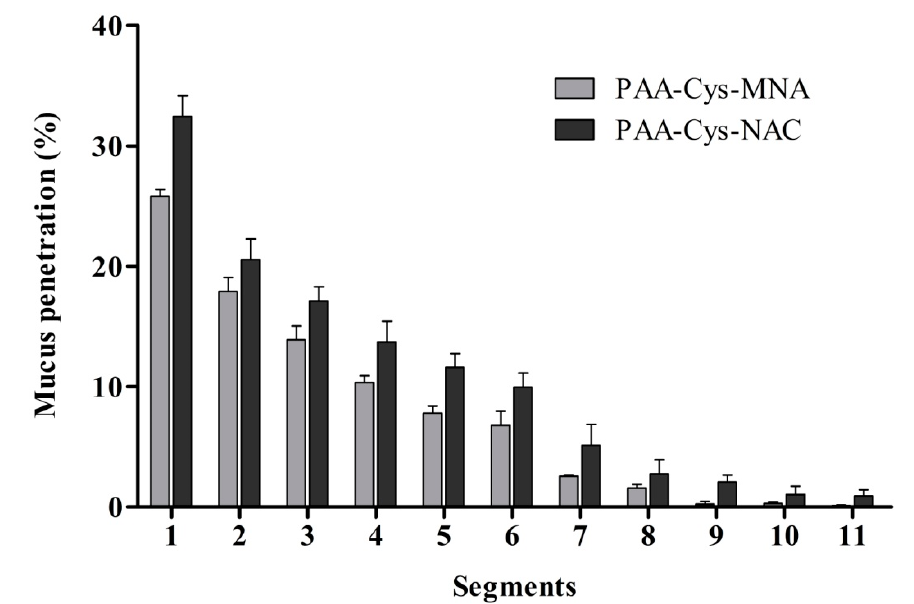
Figure 12. Mucus diffusion studies of fluoresceinamine-labeled S-protected thiolated PAA conjugates using porcine intestinal mucus by the silicon tube method. The data are shown as mean ± SD (n = 3).